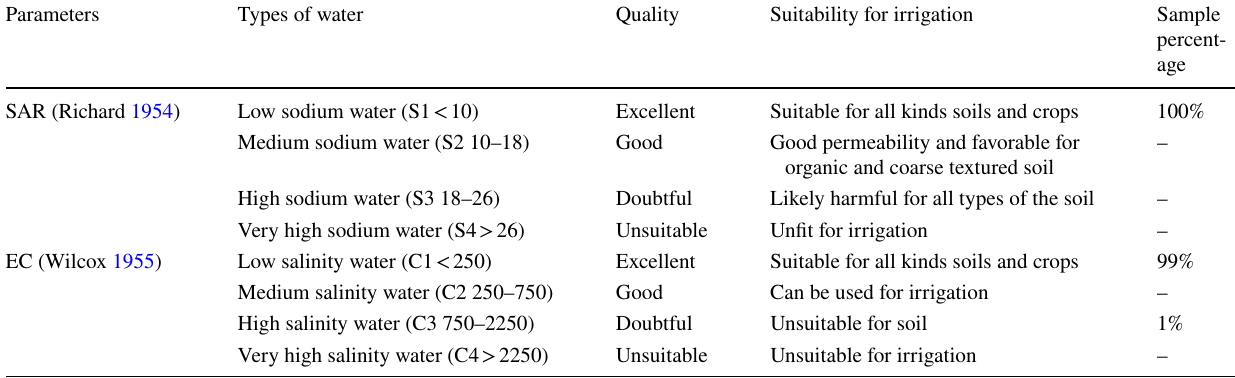
sodium percentage verses electrical conductivity Table 7 Classification of groundwater for irrigation purposes based on the SAR and EC (Adimalla et al. 2020)